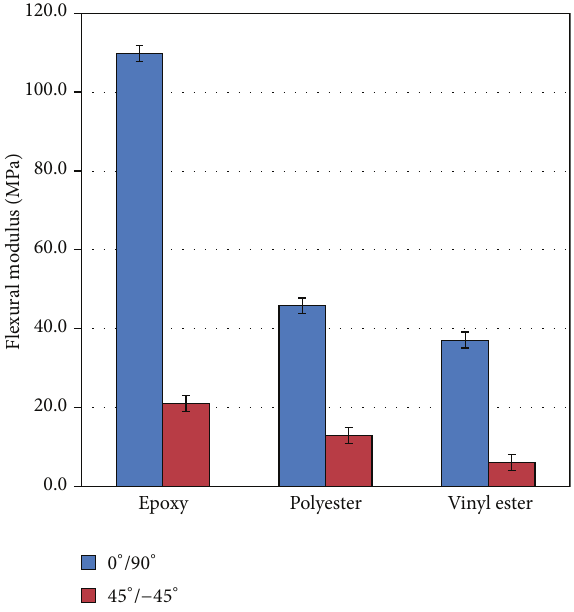
Figure 5: Flexural strength of three composites at 0 ∘ /90 ∘ and 45 ∘ / − 45 ∘ orientation.